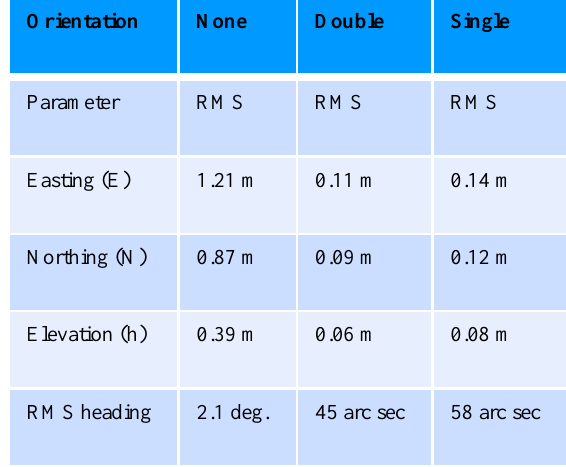
Table 2 Preliminary Results: Positioning and